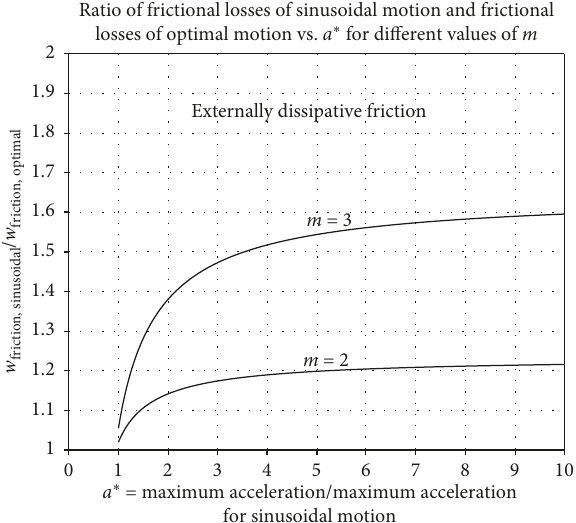
Figure 5: Ratio of work dissipated as friction with conventional piston motion relative to optimal piston motion, plotted against maximum piston acceleration, for two values of frictional exponent m (equation (2)). Maximum piston acceleration is expressed rel- ative to its maximum value for conventional sinusoidal motion.